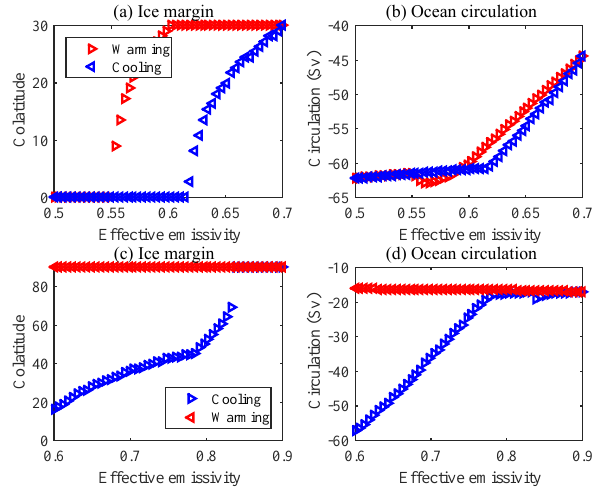
Figure 7. Hysteresis experiments, radiative forcing. Top: small ice cap regime – forcing changes in ε , warming first ( ε = 0 . 7 (cid:55)−→ 0 . 5), then cooling ( ε = 0 . 5 (cid:55)−→ 0 . 7). Resulting ice margin (left) and cir- culation (right) are shown, demonstrating a hysteresis loop in the ice margin. Bottom: large ice cap regime – with insolation set to 94% present values, forcing changes in ε , cooling first to achieve Snowball Earth ( ε = 0 . 6 (cid:55)−→ 0 . 9), then subsequent warming ( ε = 0 . 9 (cid:55)−→ 0 . 6). A strong hysteresis loop is seen in the ice margin, as the model is unable to escape Snowball Earth even as radiative forcing is raised to levels associated with ice-free states, although strong enough increases in radiative forcing will eventually melt ice away from global ice cover. Circulation remains poleward, ever in- creasing through the Snowball Earth state manual radiative forcing